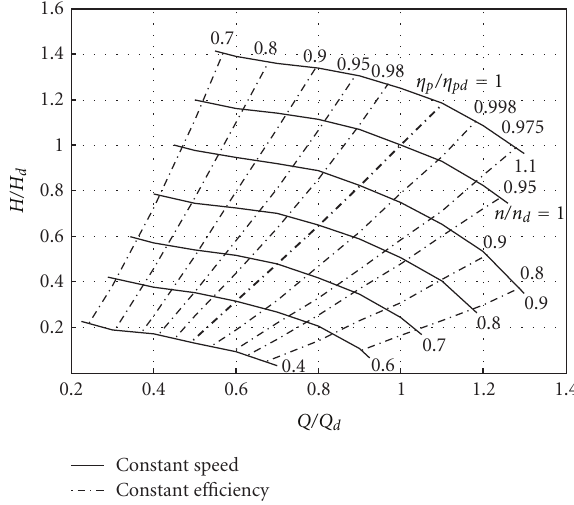
Figure 7: Generalized mixed-flow pump performance